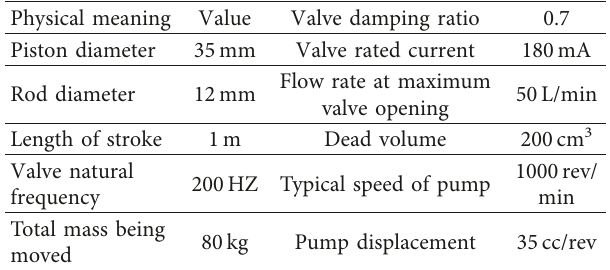
Table 2: Configuration parameters in